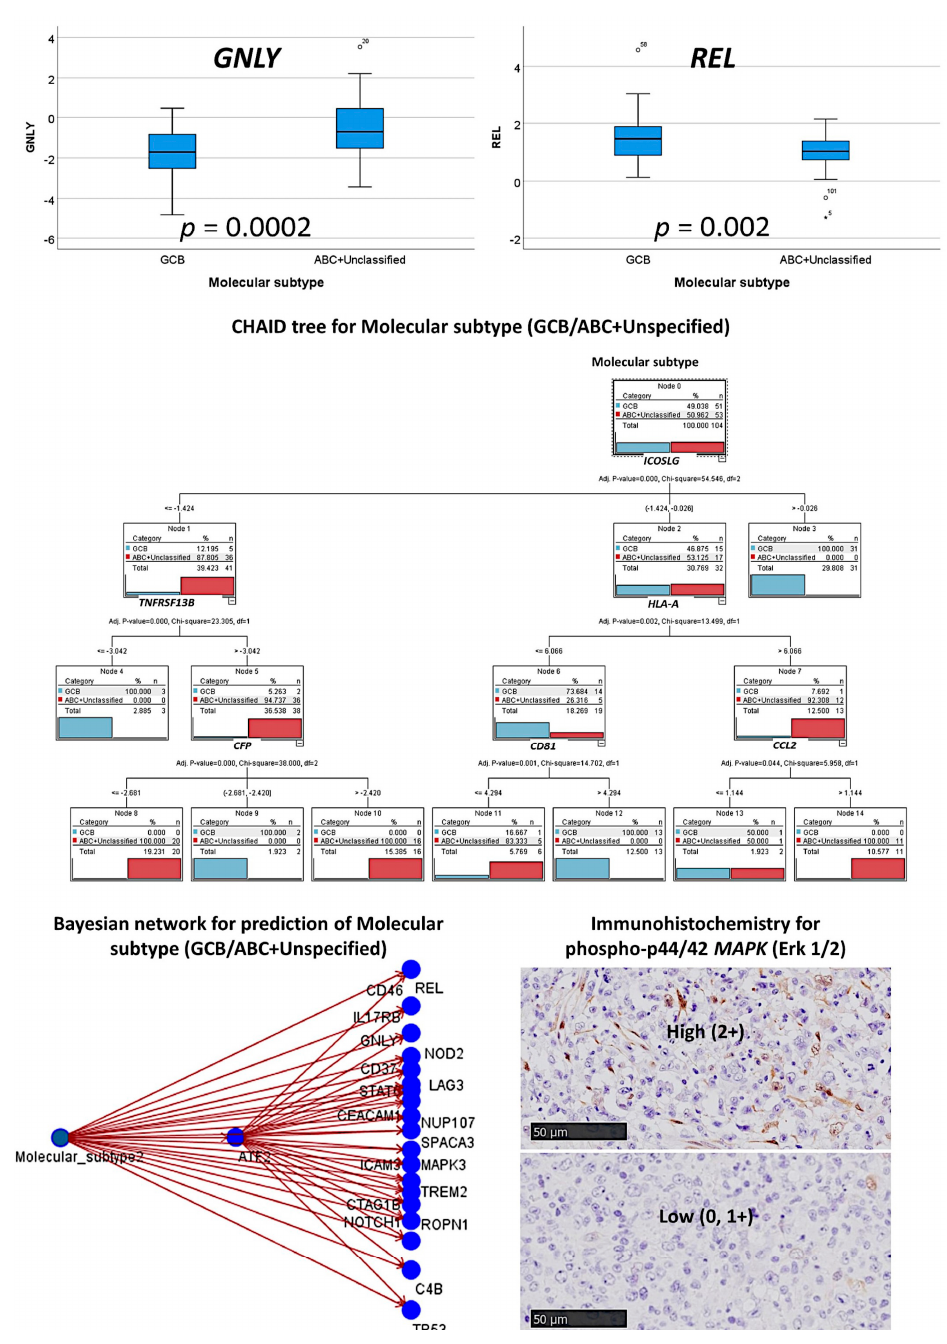
Figure 14. Other machine learning techniques for predicting molecular subtypes. The different gene expression levels between the two molecular subtypes are shown in a boxplot figure. In addition to artificial neural networks, other machine learning techniques were used. This figure shows the results of the CHAID decision tree and the Bayesian network. Finally, the predictive value of the final set of MAPK was tested in an independent series of DLBCL of 96 cases from Tokai University, and the results confirmed the association with the GCB phenotype. The expression of MAP3K was correlated with LMO2 and M2-like tumor-associated macrophage markers including CSF1R, CD163, and PD-L1. MAP3K correlated with LMO2 (odds ratio = 2.8, p = 0.039). Interestingly, though MAP3K showed histological expression similar to that of macrophages, no correlation was found with the markers (CD163, CSF1R, TNFAIP8, CASP8, PD-L1, PTX3, and